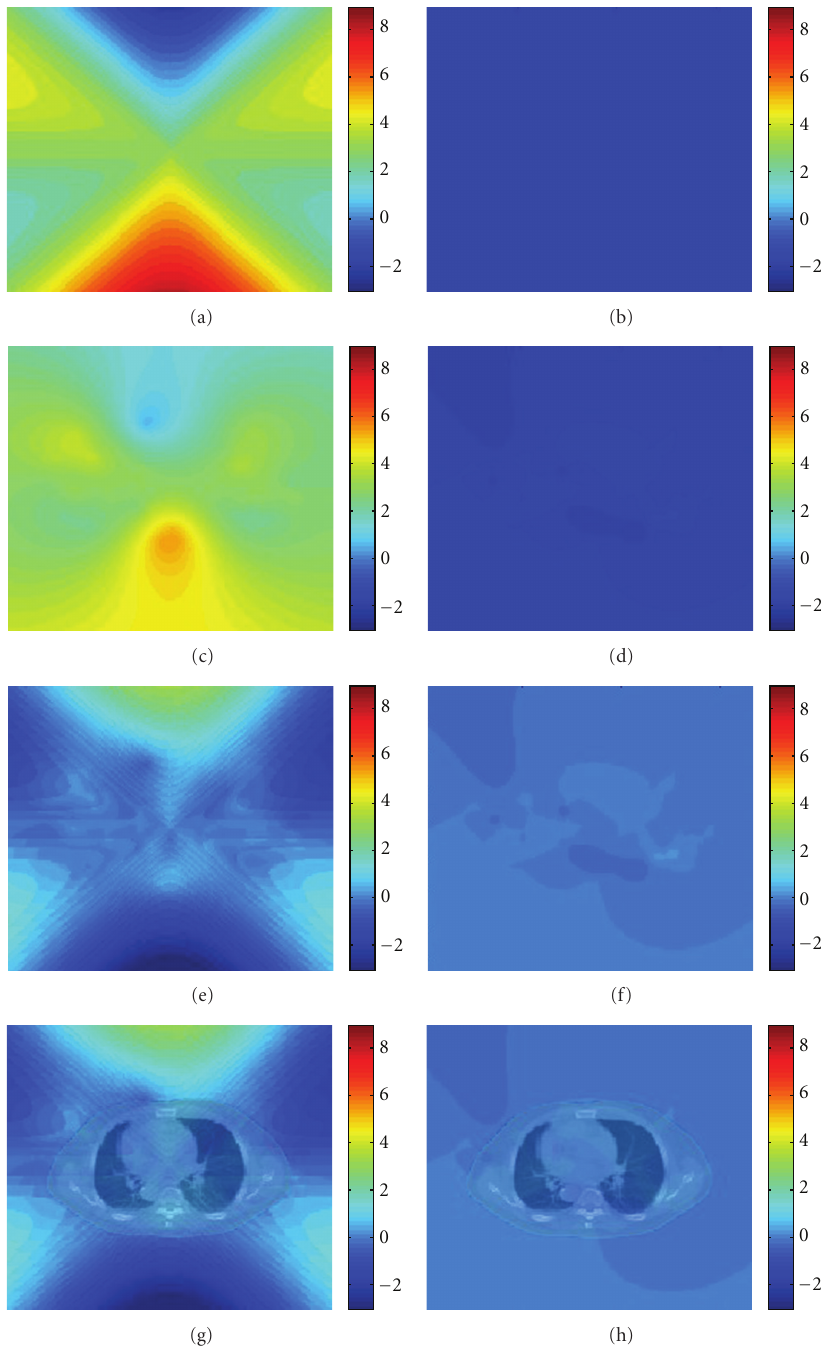
Figure 3: Displacement vectors fields of the 2D digital